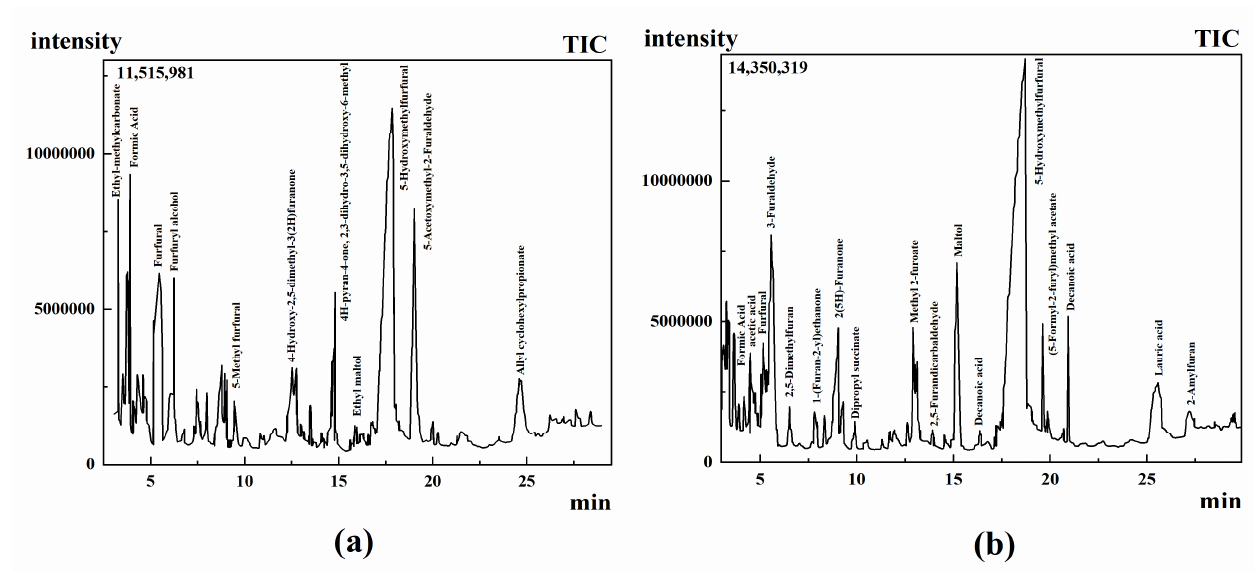
Figure 3. Chromatograms of ice cream sample 1 ( a ) and sample 2 ( b ).